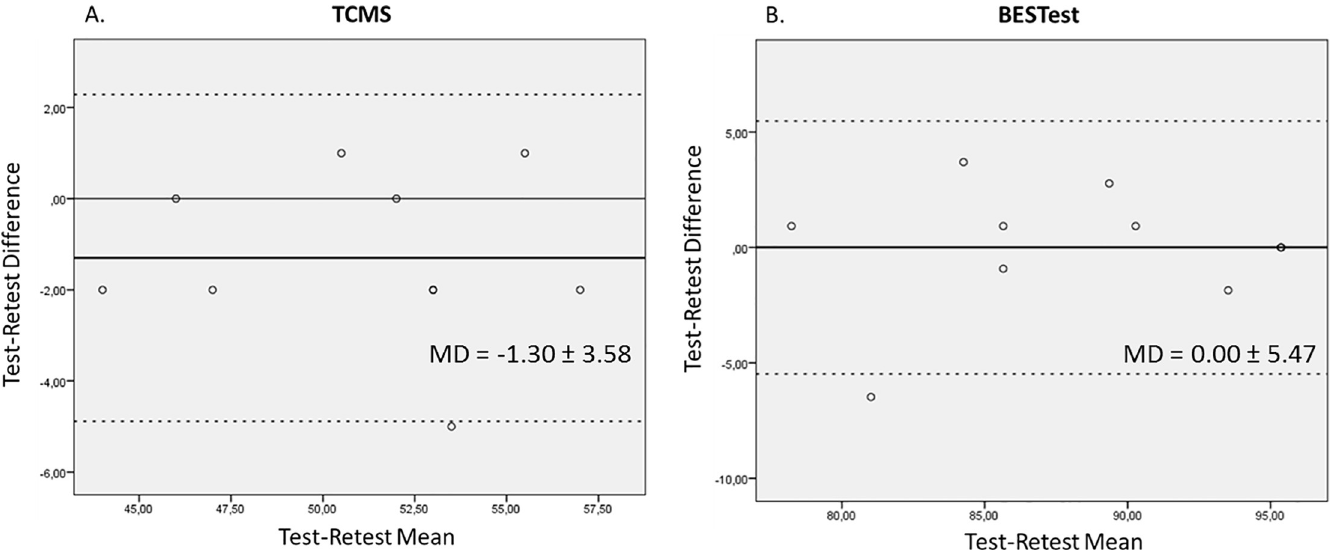
Fig 1. Bland-Altman plots for test-retest reliability of TCMS and BESTest. On the horizontal axis the mean score on TCMS and BESTest of the test and retest session is displayed. On the vertical axis the difference between test and retest is plotted. The solid thin line represents the zero axis. The bold black line represents the mean difference. The dotted lines indicate the limits of agreement. MD: Mean